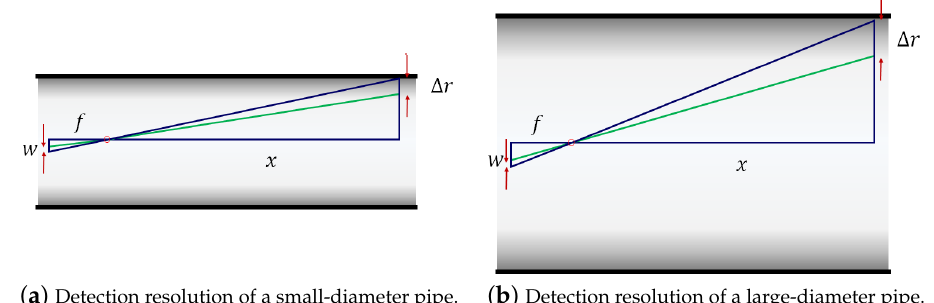
Figure 1. Detection resolution ( ∆ r ) of pipe